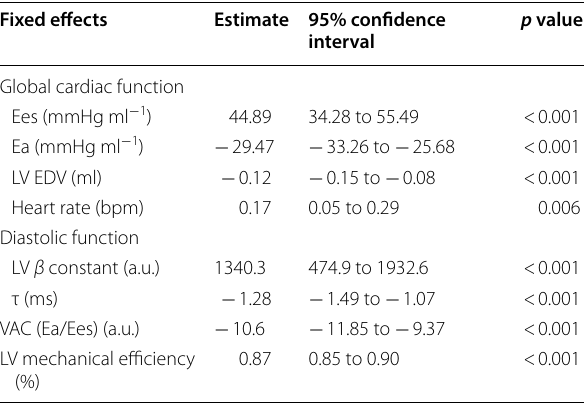
Table 3 Estimated values of different variables on left ventricular ejection fraction (LVEF) according to a linear mixed-effects model